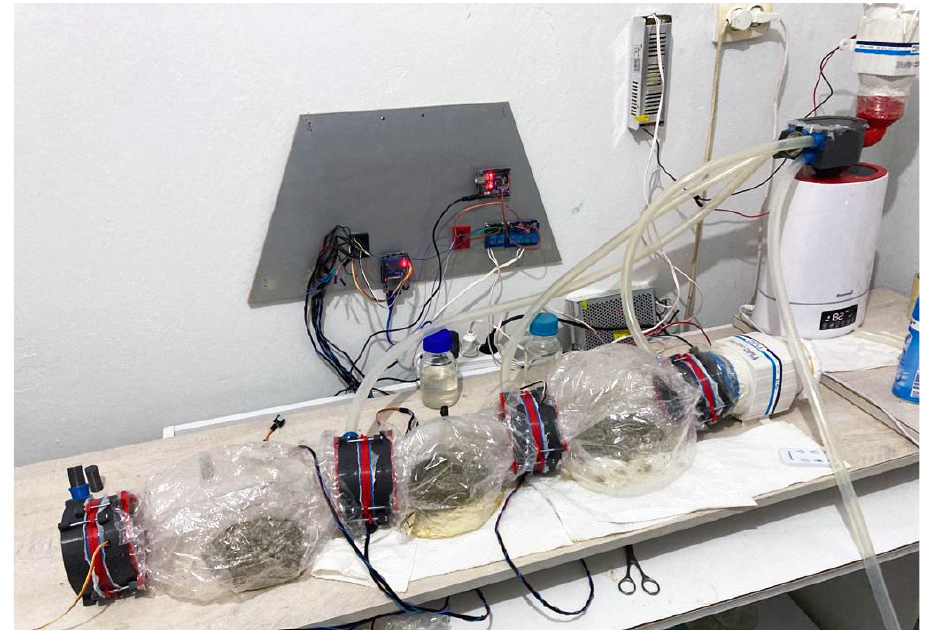
Figure 7. MCB setup for biomass experiments.